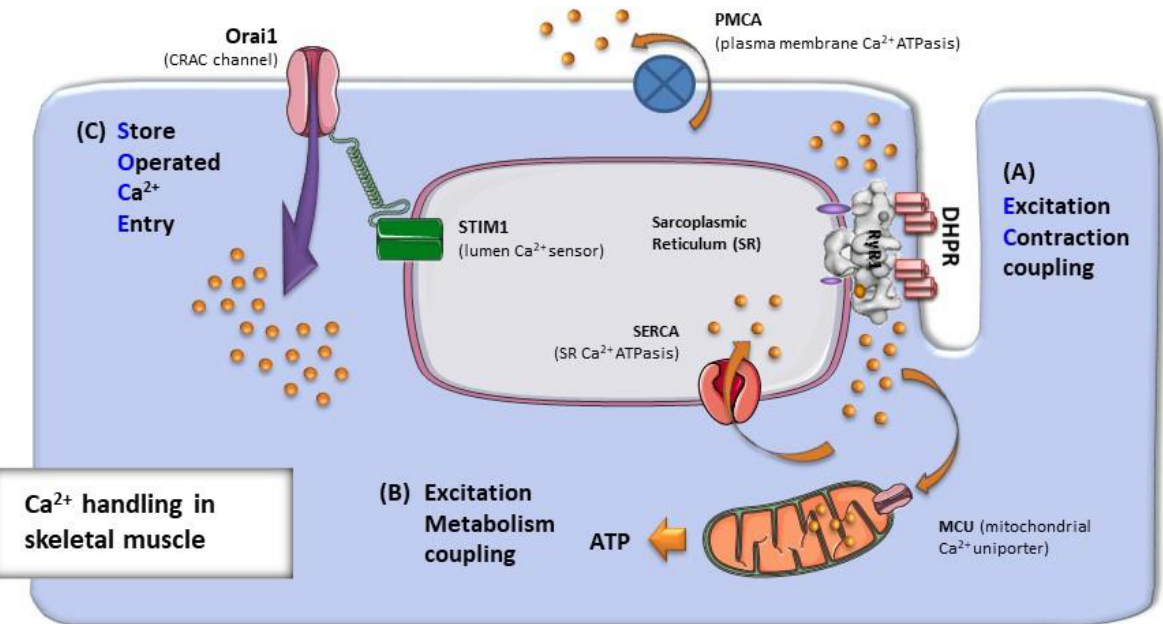
Figure 1. Ca 2+ handling in skeletal muscle fibers. Intracellular Ca 2+ concentrations in muscle fibers depend on: ( A ) the release and re-uptake of Ca 2+ from intracellular SR stores during EC coupling, which controls the contraction and relaxation of sarcomeres; ( B ) the uptake of Ca 2+ into the mitochondrial matrix during excitation–metabolism coupling, which stimulates aerobic ATP production; and finally ( C ) the entry of Ca 2+ from the extracellular space via SOCE, a mechanism that is important to limit/delay muscle fatigue.